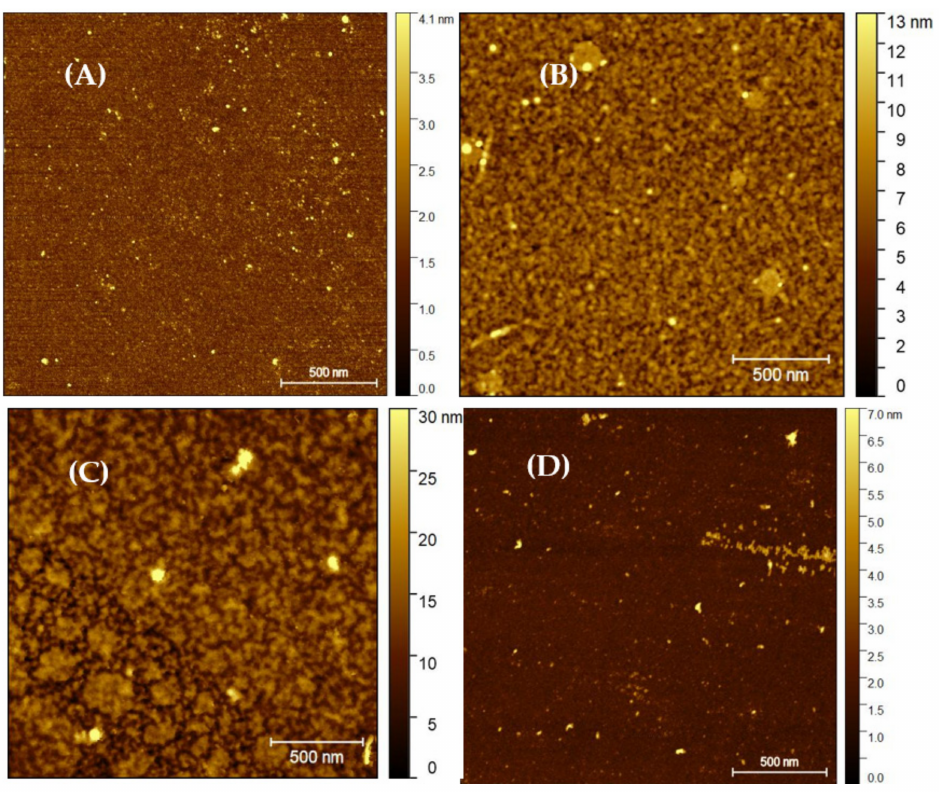
Figure 2. Non-contact AFM images: ( A ) raw silicon surface; ( B ) substrate functionalized with APTES; ( C ) thin film ended with GA on APTES; and ( D ) substrate subjected to silanization with GOPS. The size of the scanning area is 2 × 2 µ m 2